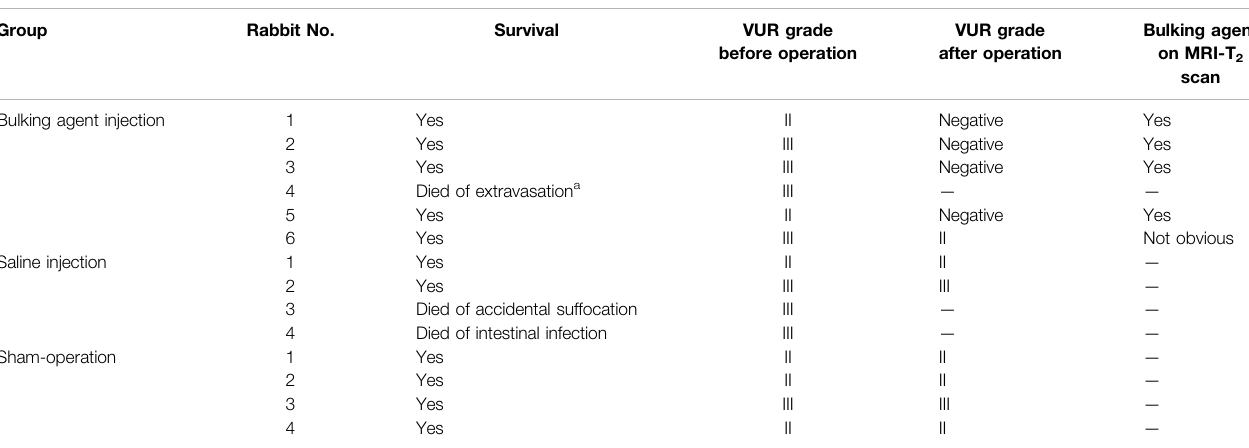
VUR grade Bulking agent before operation after operation on MRI-T 2 scan